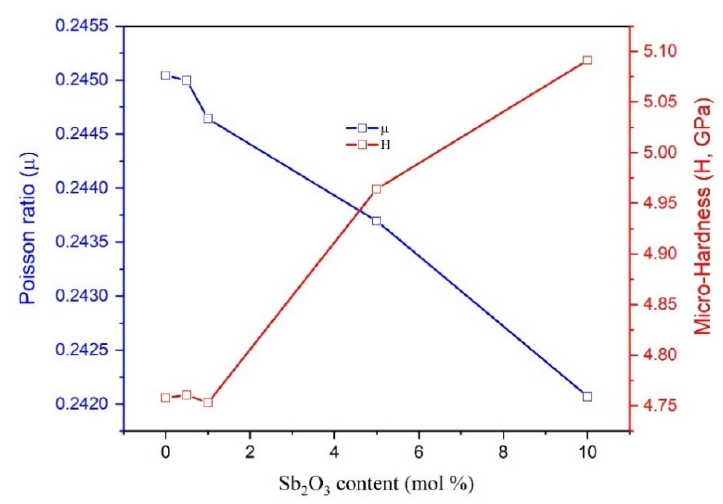
Figure 4. Variation of Poisson’s ratio and micro-hardness of the studied glasses as a function of the Sb 2 O 3 contents.